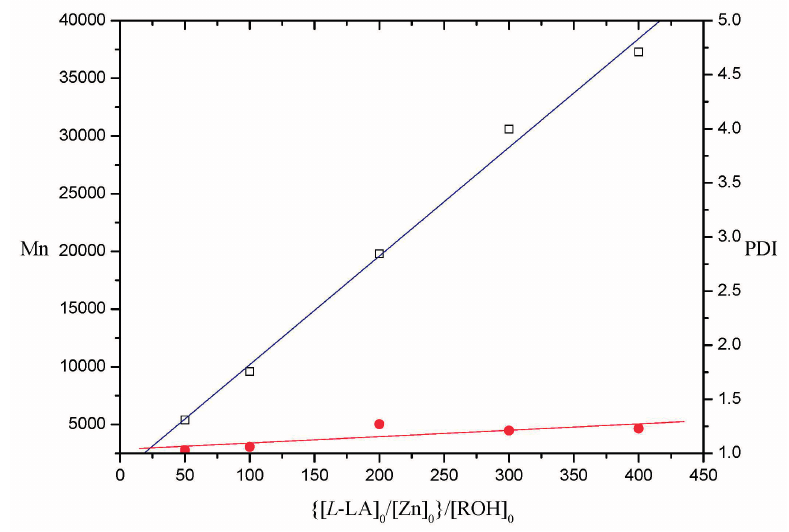
Figure 4. Polymerization of L -lactide catalyzed by 3 in toluene at 80 °C. (PDI= Mn/Mw in Table